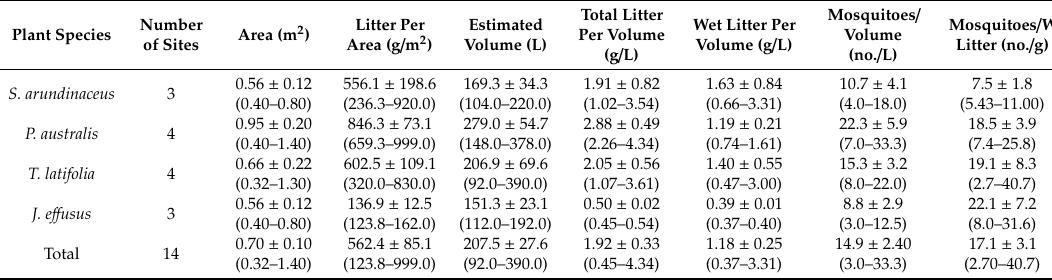
Table 1. Mean ± SE (range in parentheses) litter and mosquito parameters in roadside ditches with either S. arundinaceus, P. australis, T. latifolia, or J. e ff usus as the dominant emergent plant species. All litter was dried before